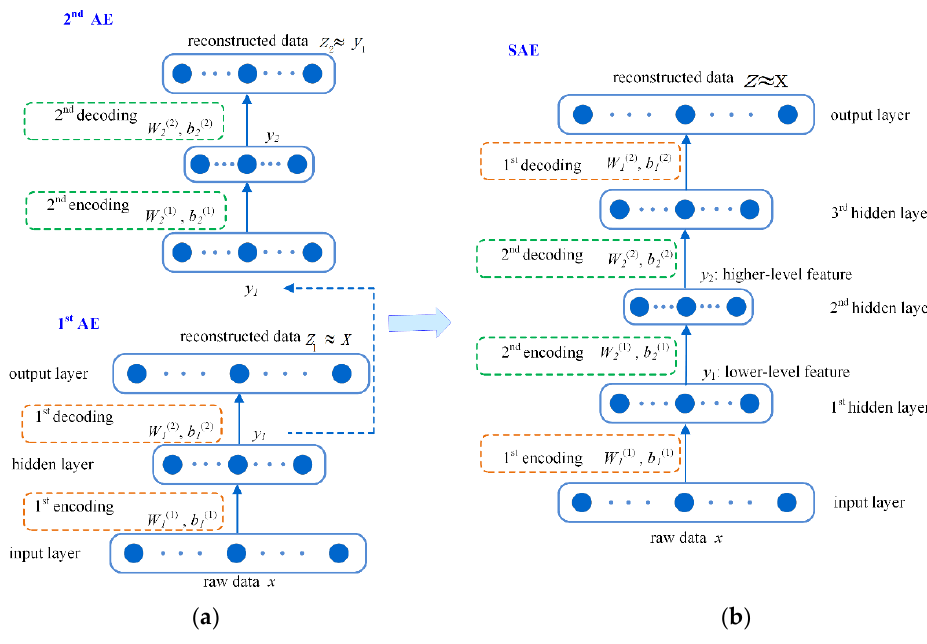
Figure 1. ( a ) Autoencoder (AE) and ( b ) stacked Autoencoder (SAE).